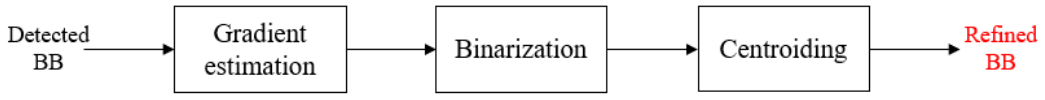
Figure 6. Main steps of the image processing approach to refine the detected BB. An image crop is obtained from the detected bounding box. The gradient operator is applied within this image portion and the gradient image is then binarized. Finally, the centroid of the set of pixels highlighted in the binarized image is computed and a refined BB is centered around this point.